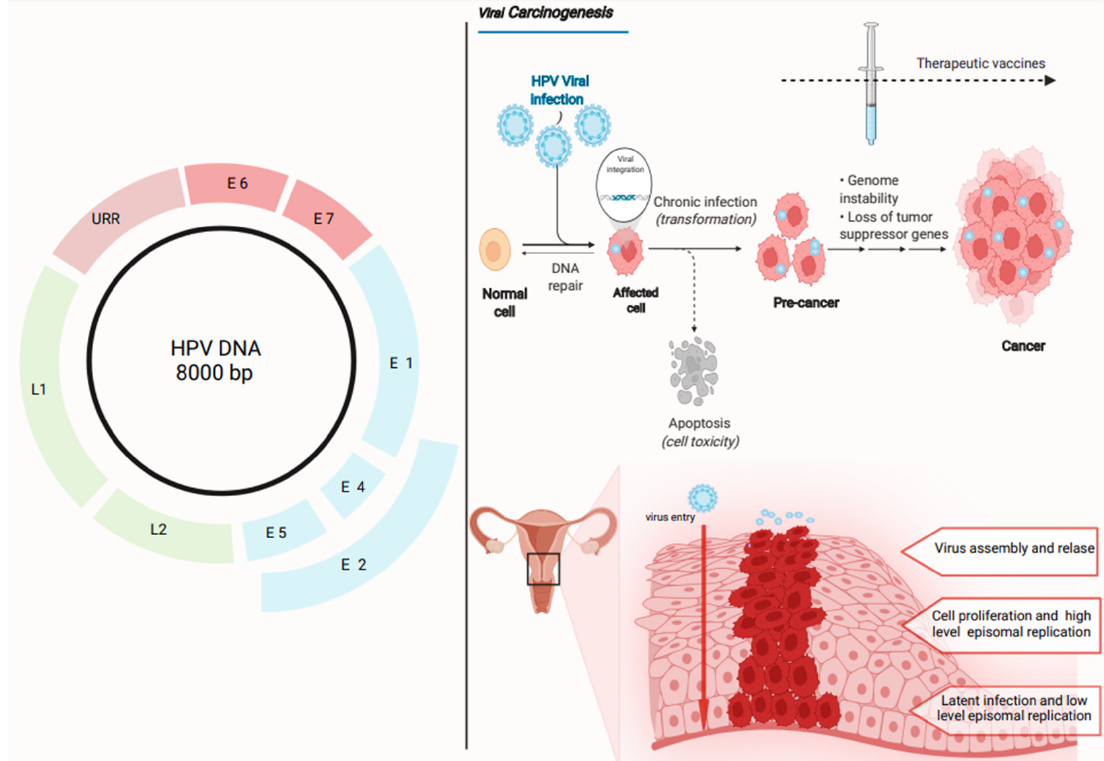
Figure 1. HPV genome structure (left) and the HPV pathway of infection and neoplastic transformation of cervical epithelial cells with the possible application of therapeutic vaccines (right). Legend: URR: Upstream Regulatory Region; E: early protein; L: late protein. Figure created with BioRender.com (accessed on 15 February